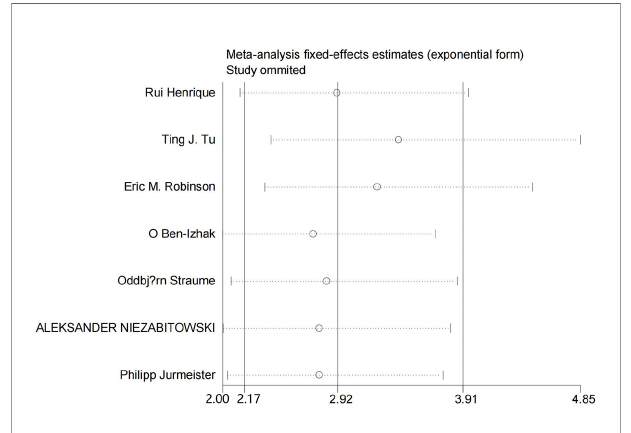
FIGURE 3 | Sensitivity analysis for OS.